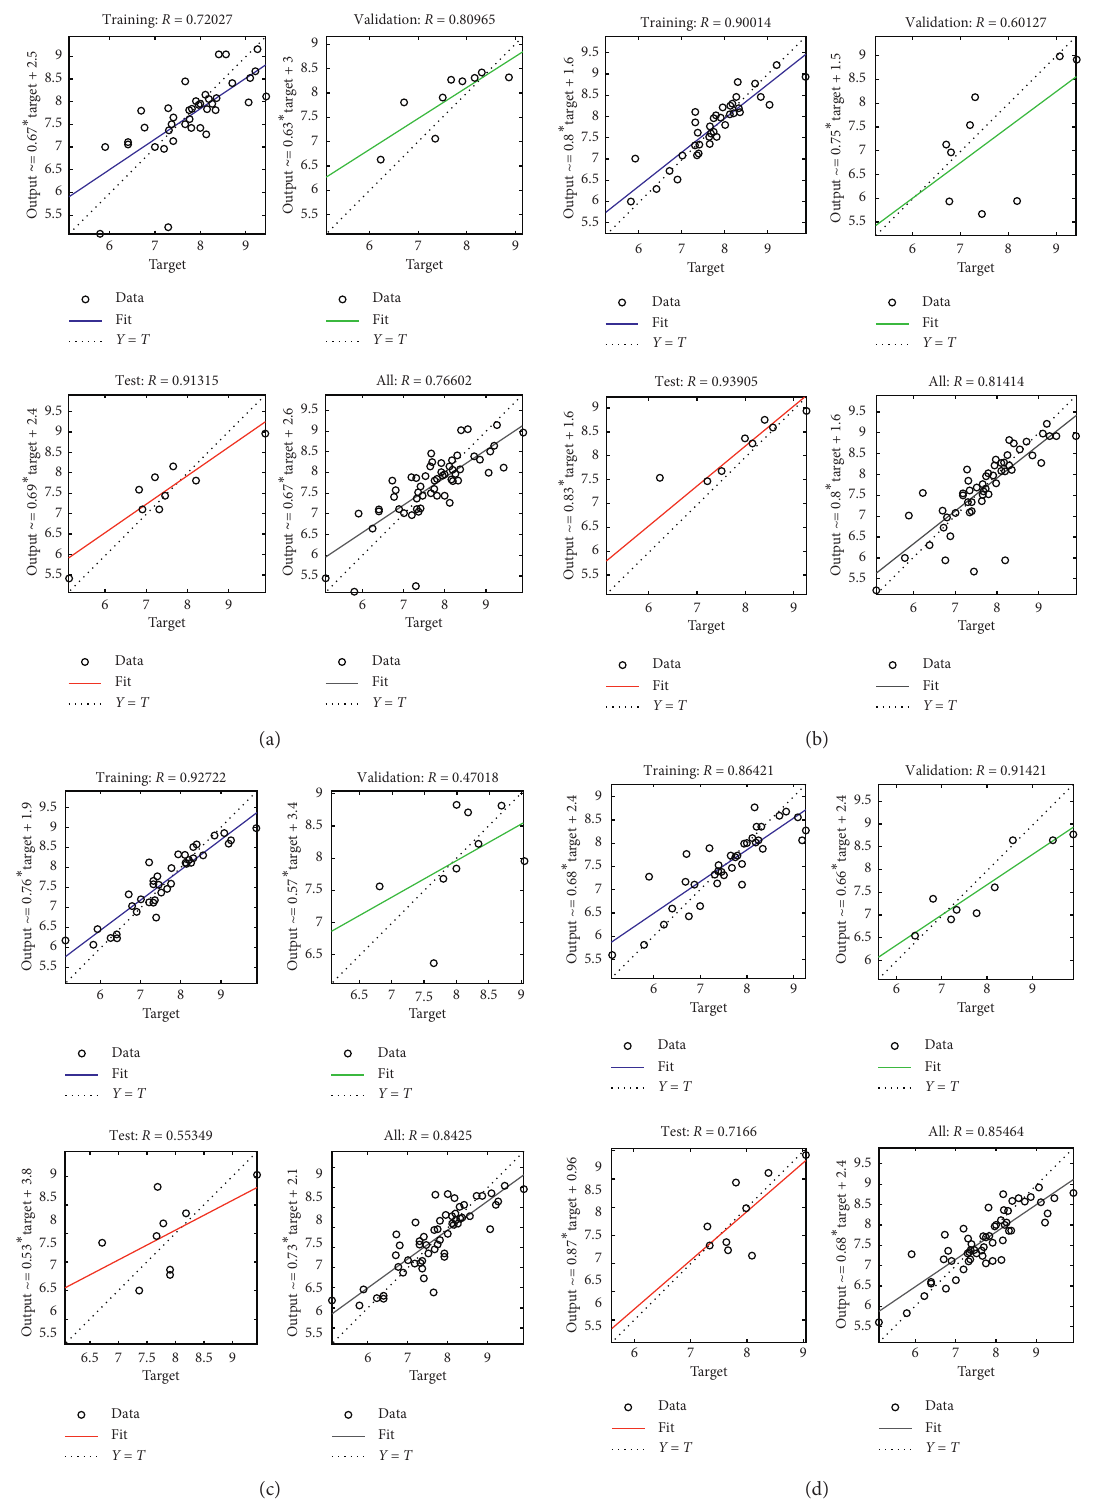
Figure 10: FNN-based predictions of DO with (a) EC, TP, and TN; (b) EC, TP, TN, and pH; (c) EC, TP, TN, pH, and temperature; and (d) eight (8) input WQ